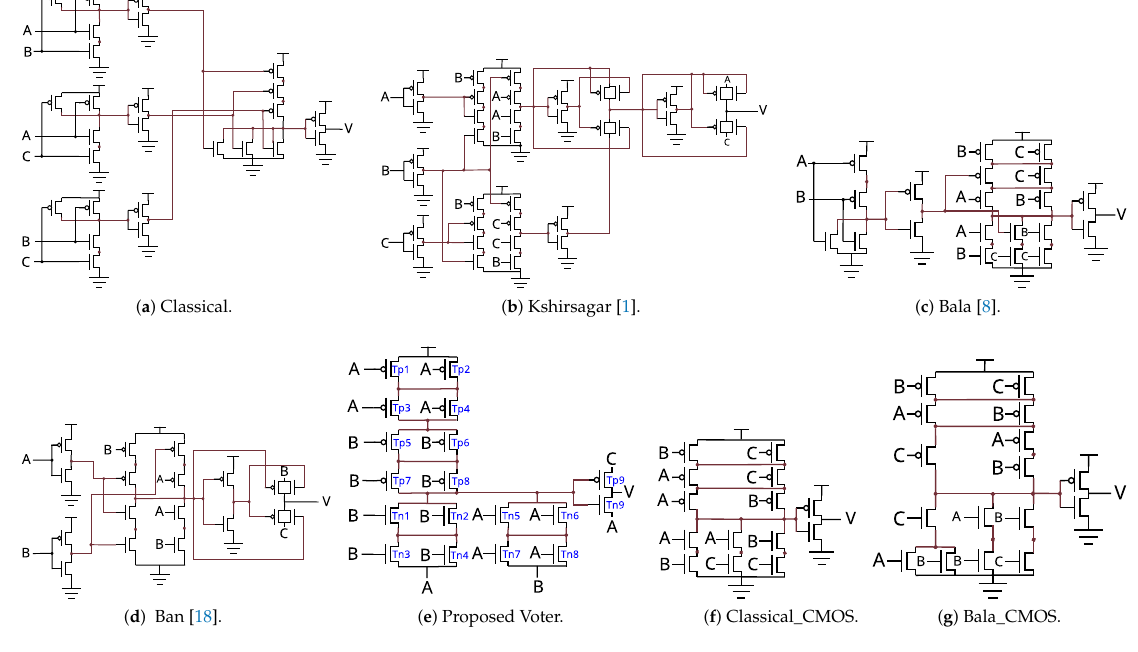
Figure 4. Voters Architectures.